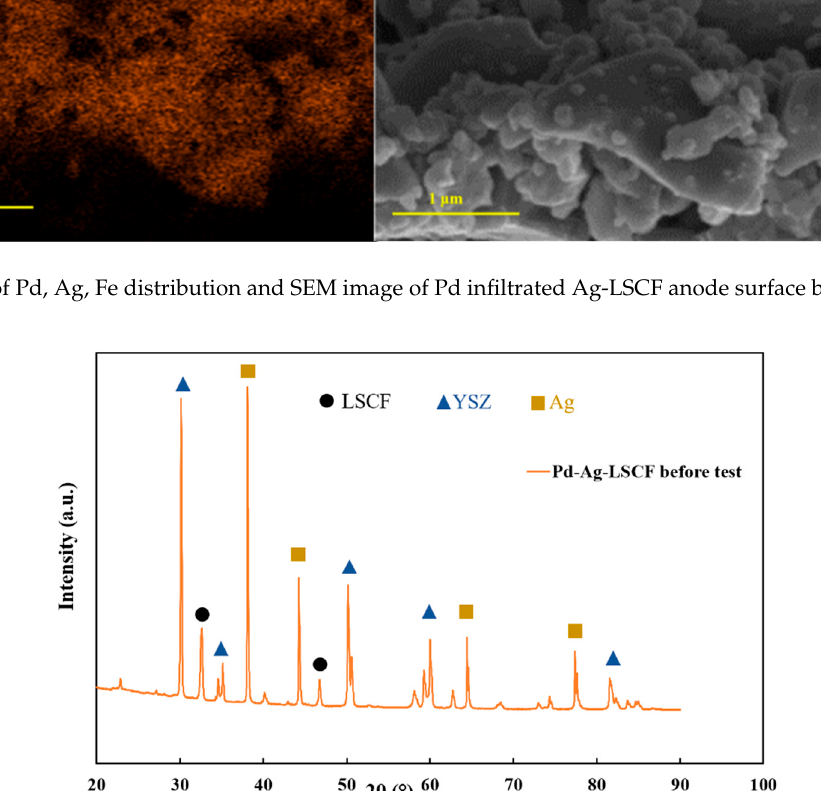
Figure 5. X-ray diffractograms collected from the Pd infiltrated Ag-LSCF anode surface before testing (LSCF PDF 04-019-6360, YSZ PDF 04-016-2113 and, Ag PDF 00-004-0783).